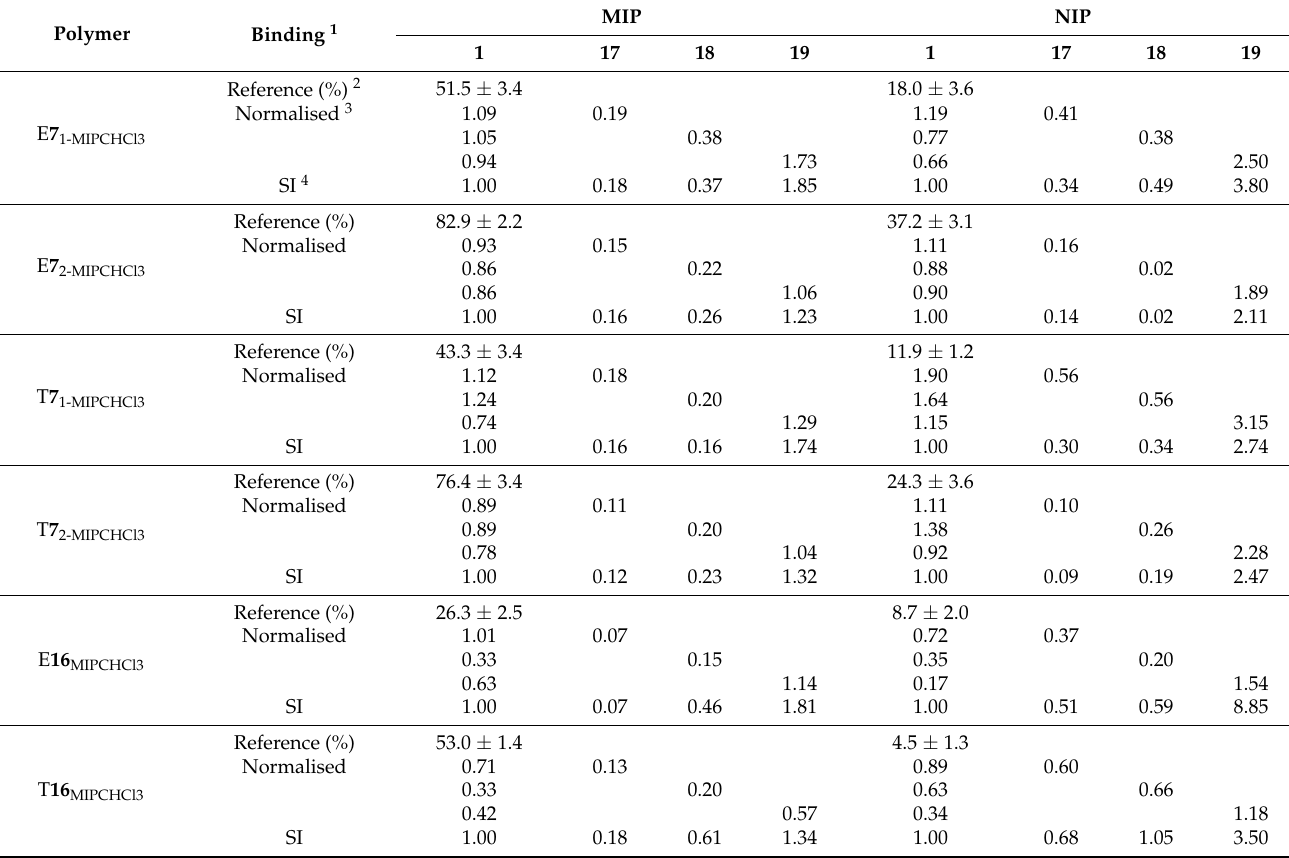
Table 3. Binary competition results for 1 -MIPs against cocaine ( 17 ), morphine ( 18 ) and ephedrine ( 19 ).